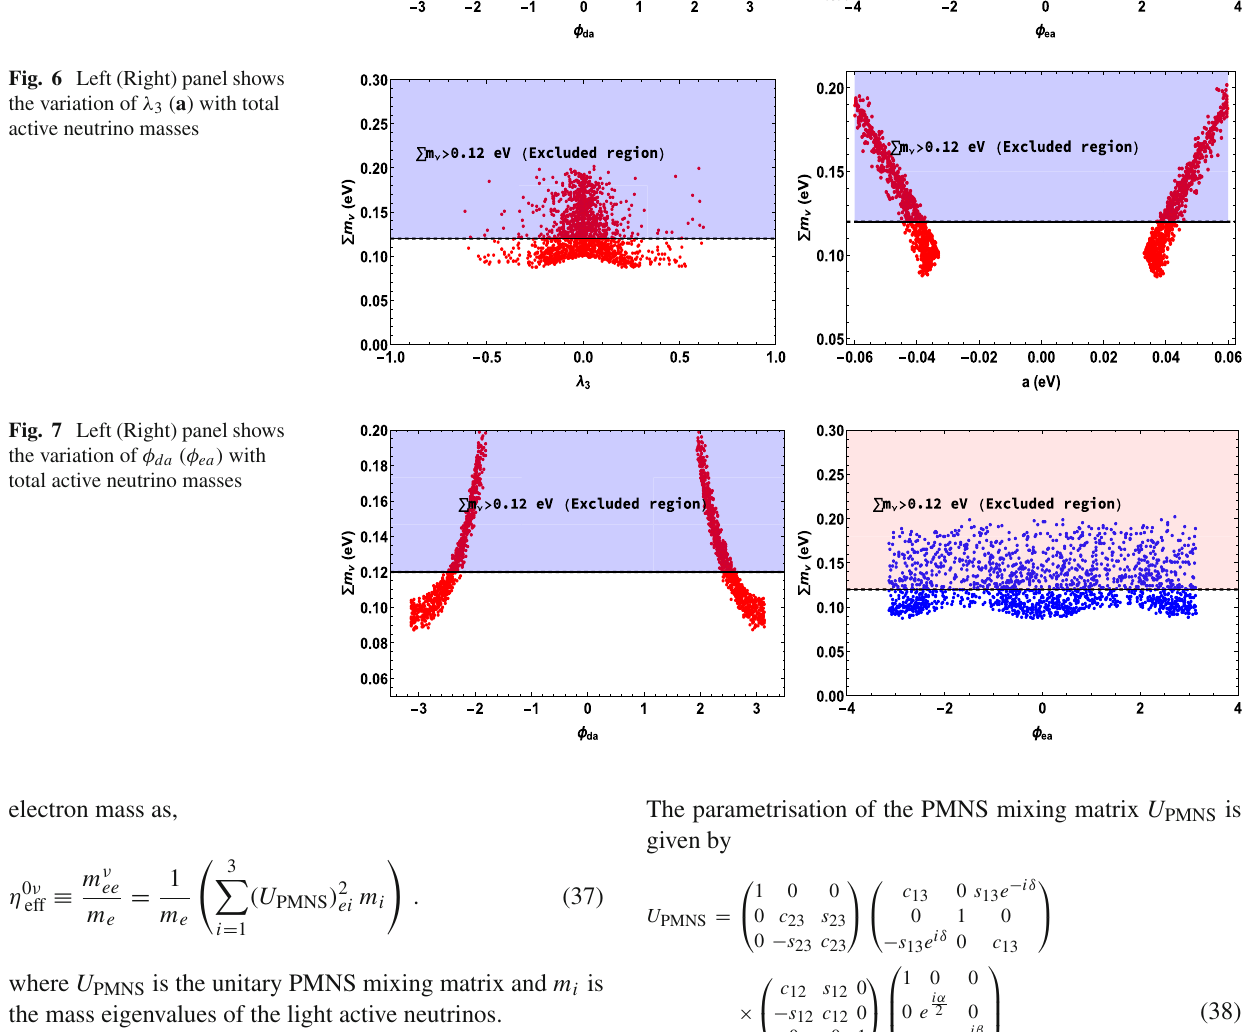
Fig. 6 Left (Right) panel shows the variation of λ 3 ( a ) with total active neutrino masses